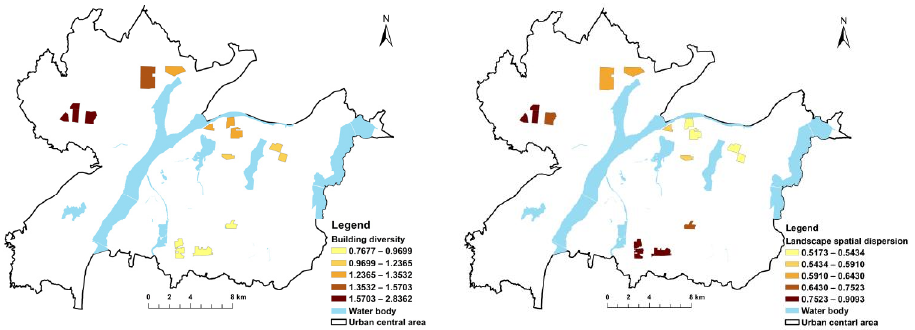
Figure 3. GWR results for industrial function zone.